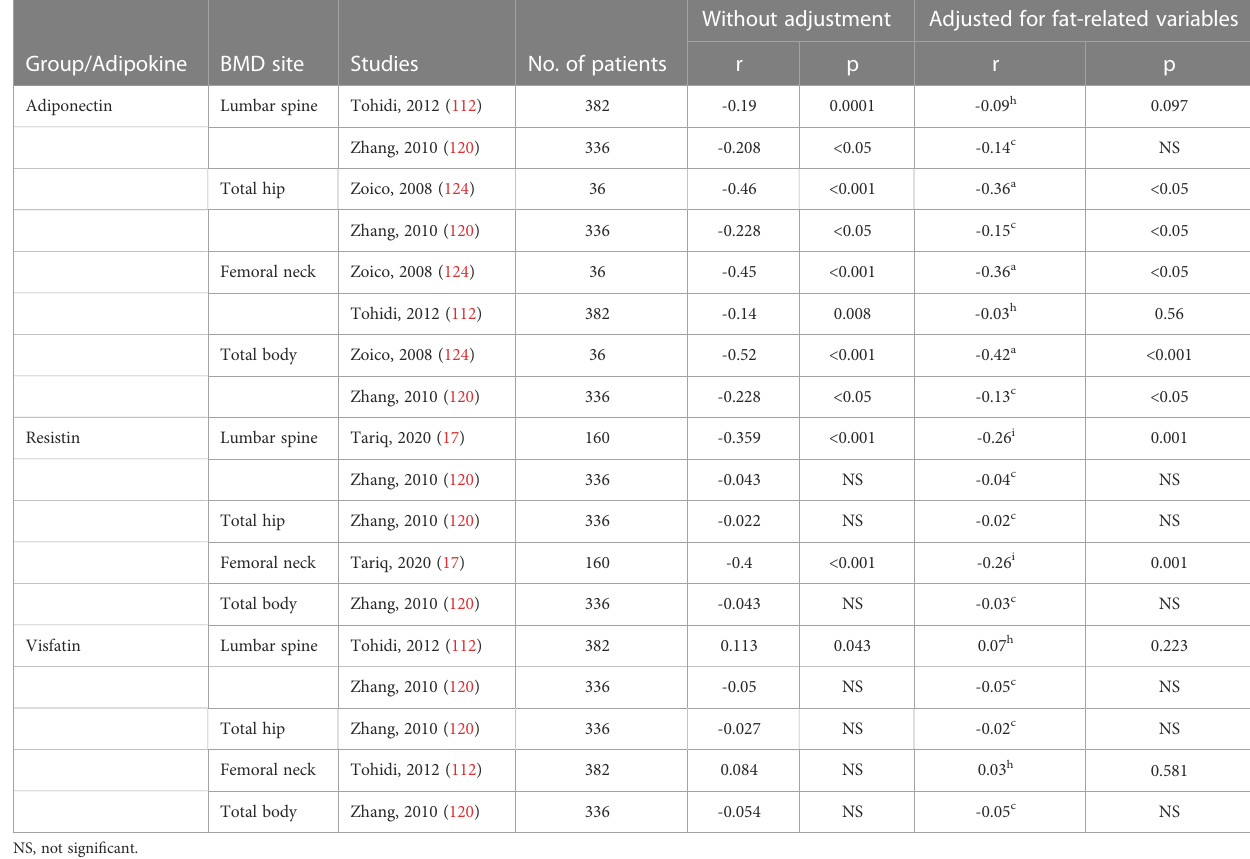
BMD reduction and leptin, and an inverse association between lumbar spine BMD reduction ( b = -0.002) and adiponectin (63). Based on these results, plasma adipokines or ghrelin levels had a weak or no association with the prediction of BMD changes.